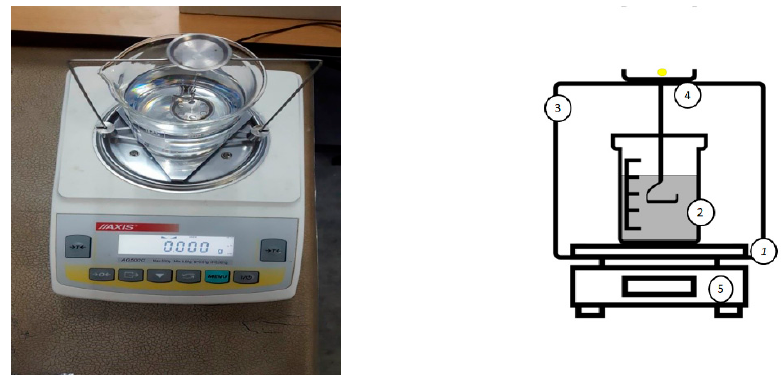
Figure 1. Schematic diagram of the equipment used for determining density.